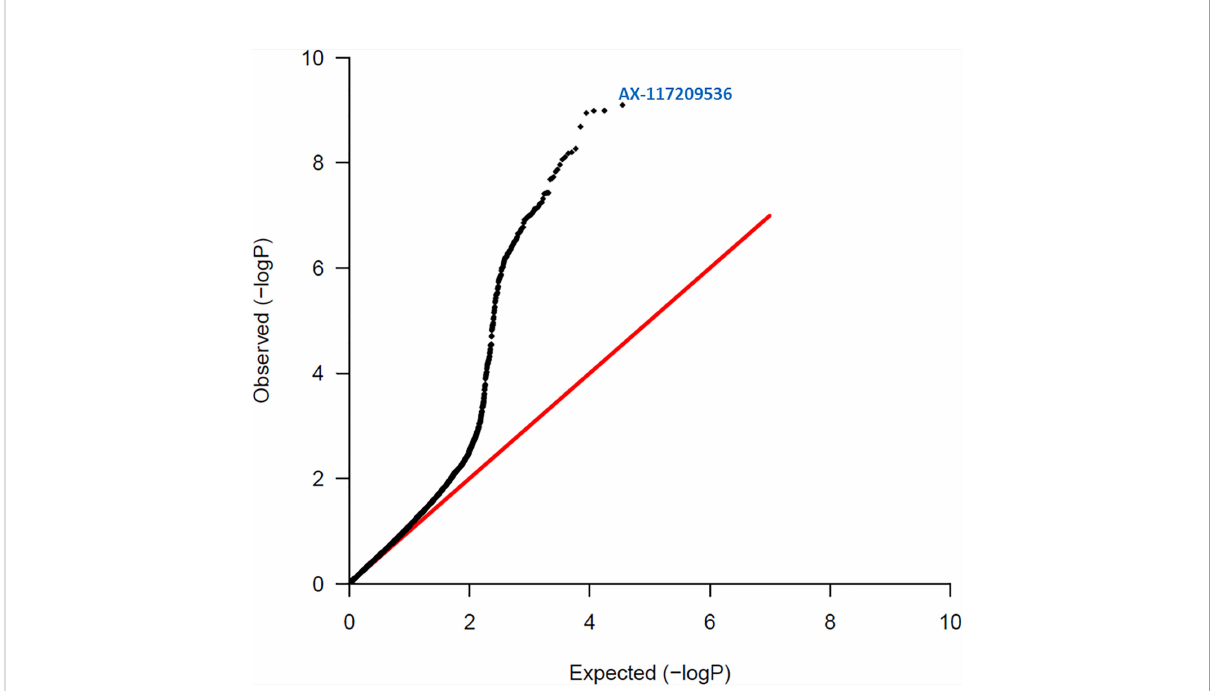
FIGURE 2 Quantile – Quantile plot of red rot SNPs. Expected normal distribution of p-values assuming no associations (null hypothesis) is given on the x axis, and the observed p-values on the y axis. The red line indicates the expected trend if observed p-values were normally distributed. The most signi fi cant SNP (AX-117209536) is indicated on the fi gure and was associated with red rot disease at p = 8.00 x 10 -10 .